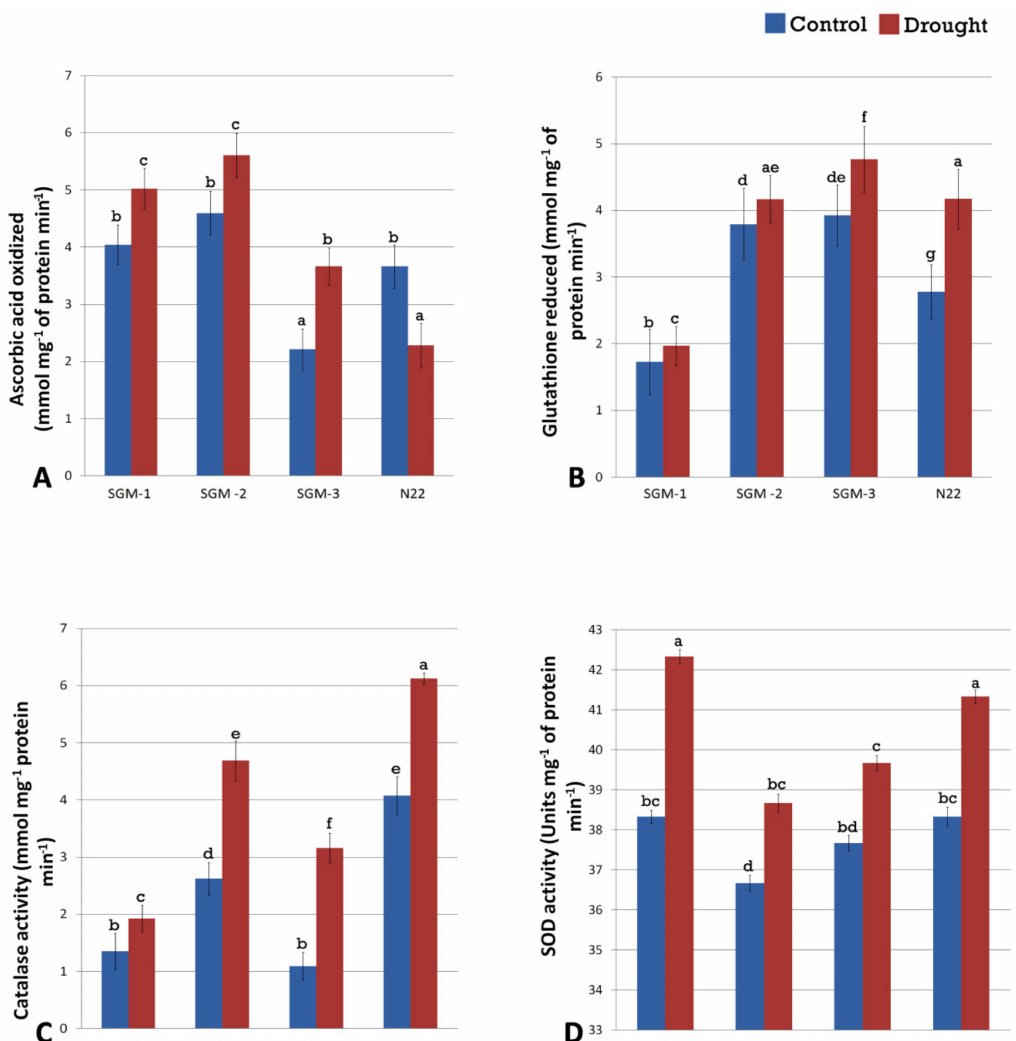
Figure 6. Enzyme activities of the enzymes involved in oxidative stress management, ( A ) ascorbate peroxidase (APx), ( B ) glutathione reductase (GR), ( C ) catalase (CAT) and ( D ) superoxide dismutase (SOD) in the three stay-green mutants (SGM-1 to SGM-3) and the wild type, Nagina 22 (N22) (a to f denotes significance at p (0.05) determined from one way ANOVA post hoc Tukey